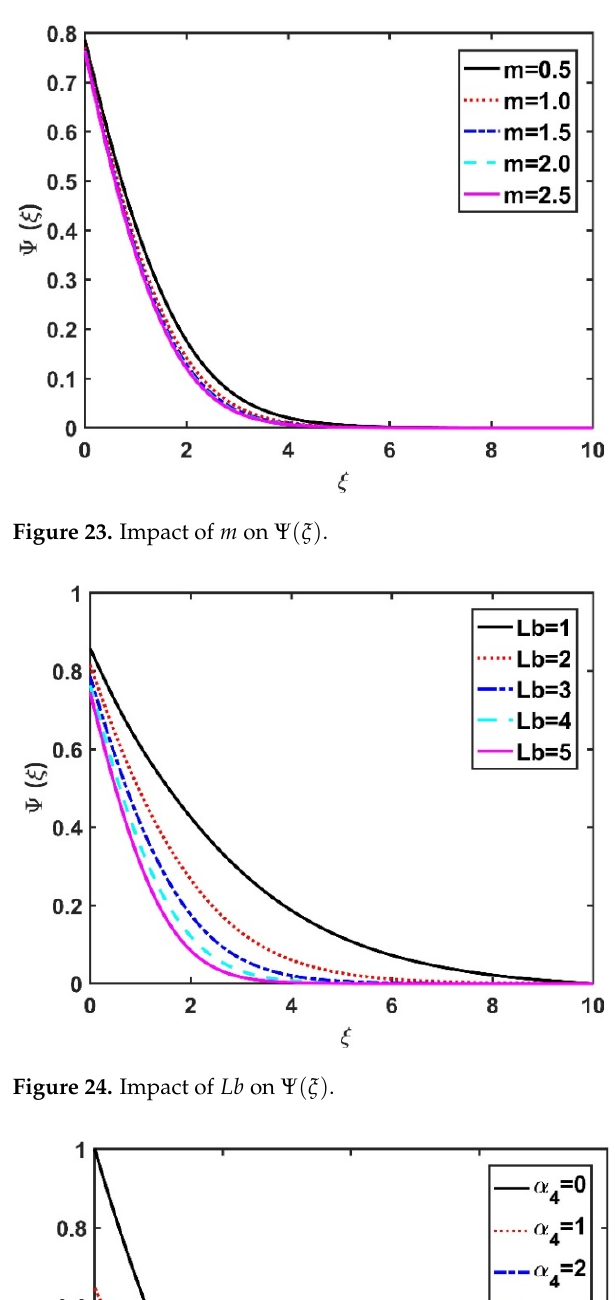
Figure 22. Impact of 𝑀 on Ψ(cid:4666)𝜉(cid:4667) .